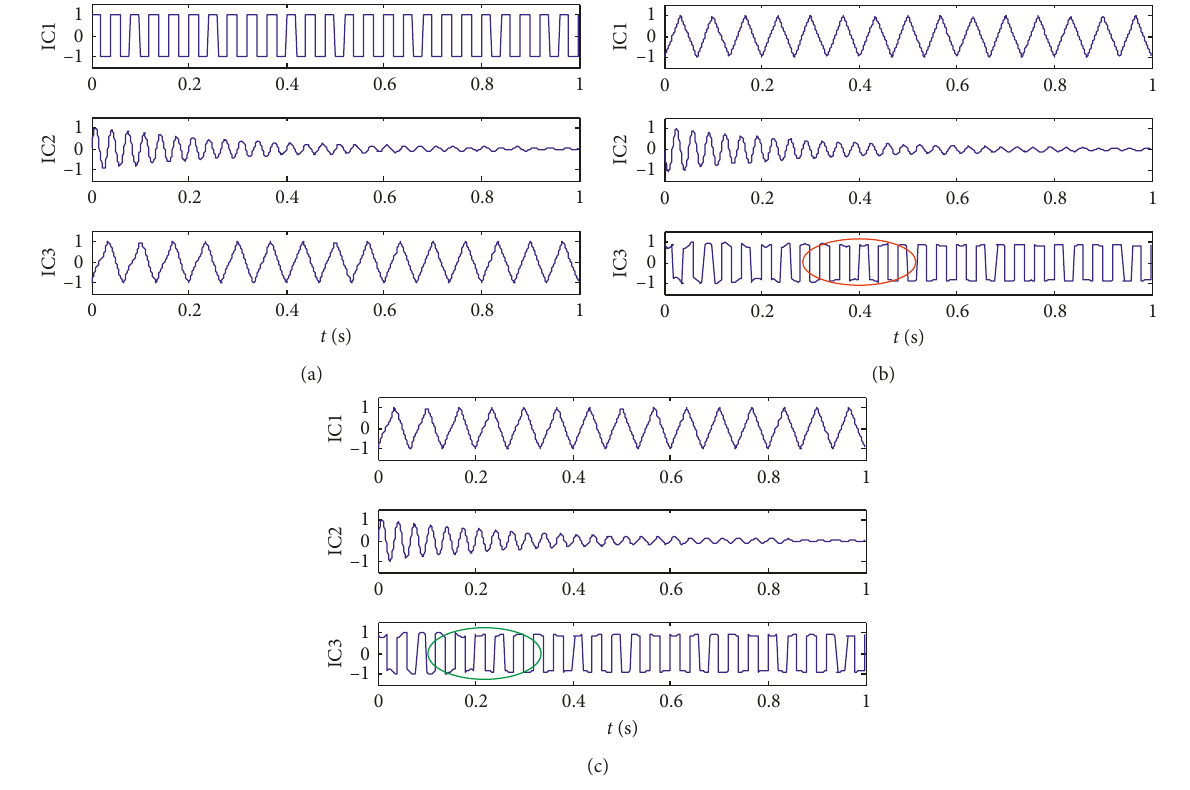
Figure 5: The calculation results by (a) RobustICA, (b) FastICA, and (c) JADE. Table 2: Quantitative index on the performance of three ICA methods.